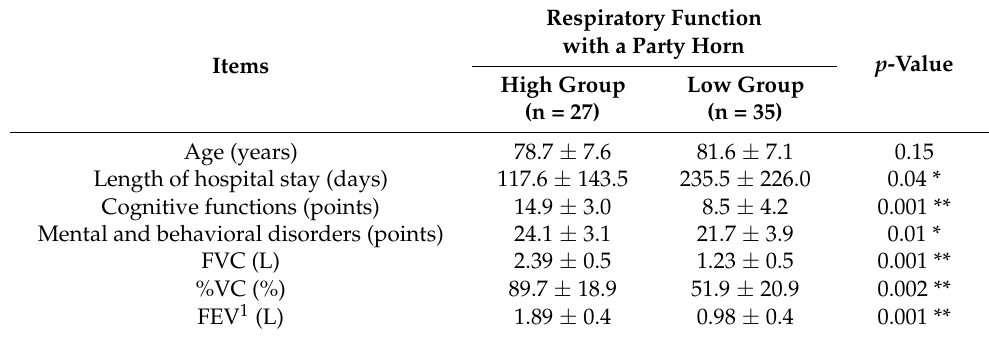
Table 1. Comparison of various factors associated with respiratory function between the two groups.